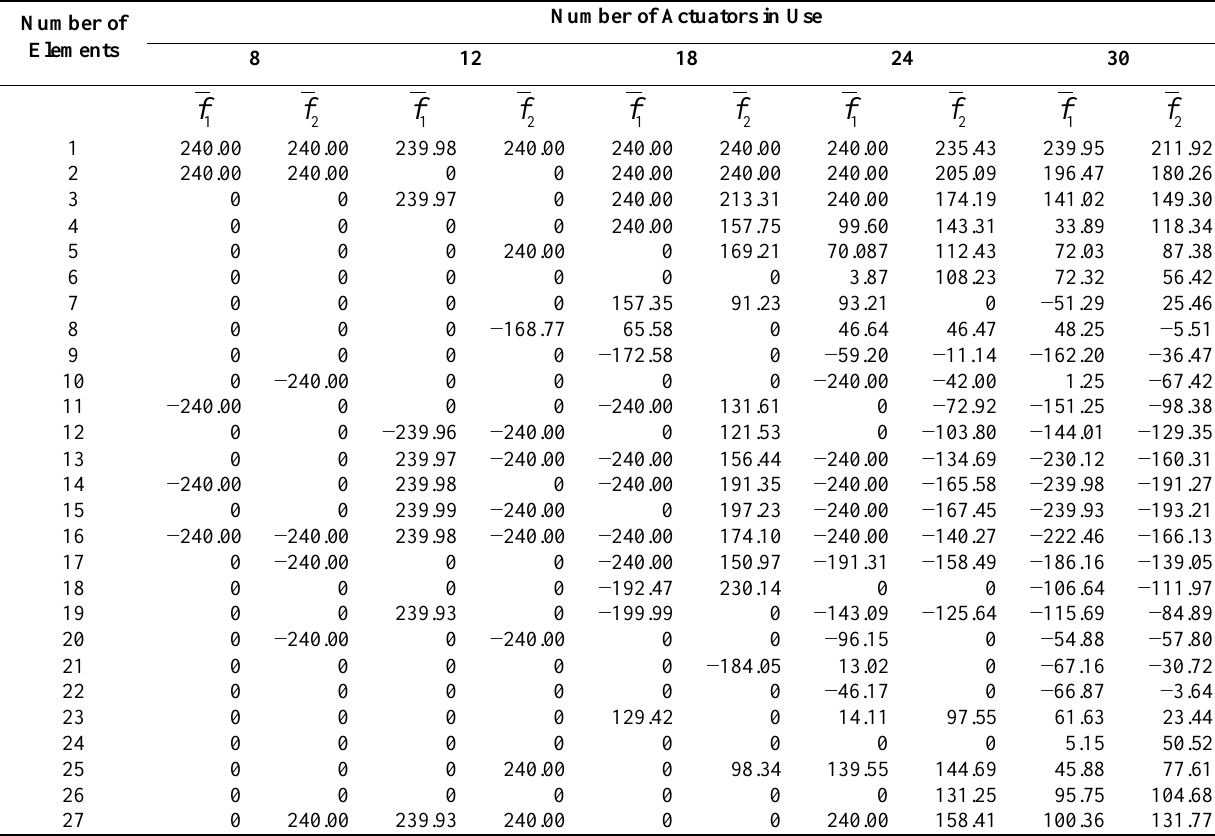
Table 3. Optimal Location and voltages of actuators within the 30 finite element mesh for Clamped−Clamped